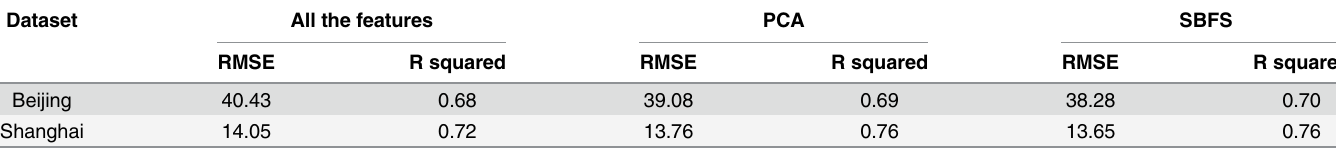
Table 5. The performance comparison between all the features and the optimized feature subsets for Beijing and Shanghai ’ s dataset.